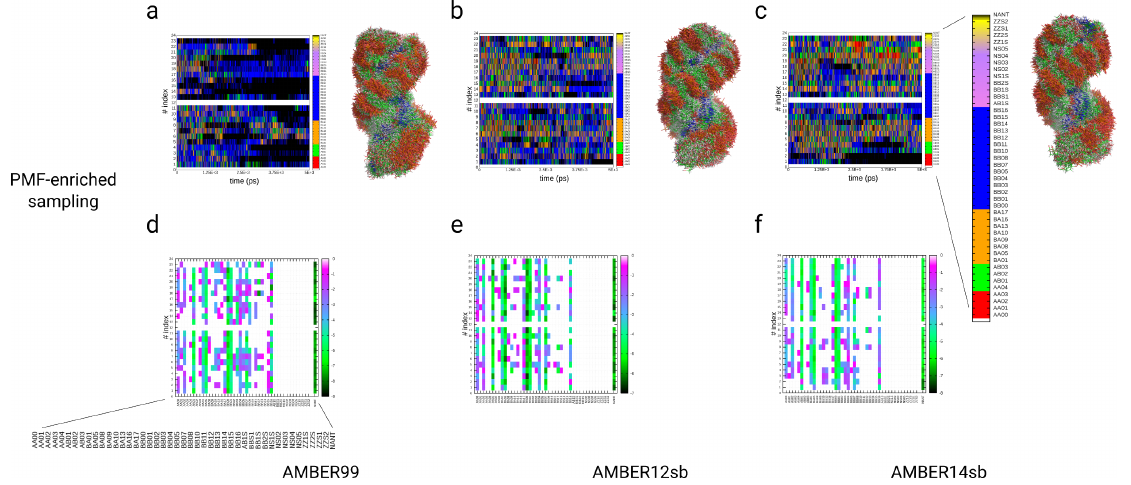
Figure 6. NtC assignment analysis of three PMF-enriched simulations of the Dickerson–Drew DNA dodecamer (with a stronger coupling parameter α = 10 − 8 ) (see Methods section). The overlaid structures of each trajectory are displayed on the right side of the panels ( a – c ). ( a – c ) NtCs as a function of time from the simulation using different conventional force fields ( H ( A ) ): AMBER99 ( a ), AMBER12sb ( b ), and AMBER14sb ( c ). ( d – f ) Free energy partition ( ∆ F = − k B T ln ( p / p min ) ) as a function of the conformer class index and the step-index along the DNA sequence from the simulations using AMBER99 ( d ), AMBER12sb ( e ), and AMBER14sb ( f ). The colored bar expresses the energies in units of k B T